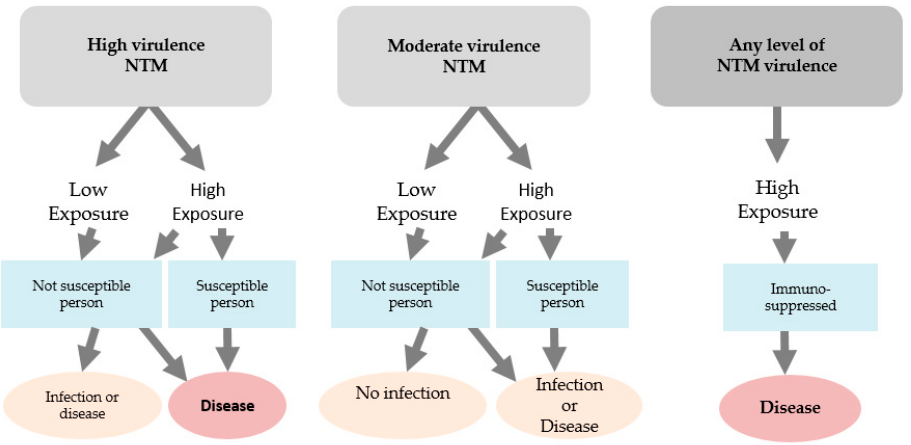
Figure 2. A hypothetical model explaining the persistence and/or reinfection of Nontuberculosis Mycobacteria (NTM) and the establishment of Mycobacterium bovis bacillus Calmette–Guérin (BCG) vaccine interference. Mouse models clearly indicate that TH1 immunity predominates in situations where this pathogen can be cleared, but there is little evidence, explaining its survival and chronic disease. One hypothesis involves T cell plasticity. The inflammatory Th17 response becomes dominant, resulting in loss of a protective Th1 response and its replacement by cells that can continually drive low-grade inflammation.